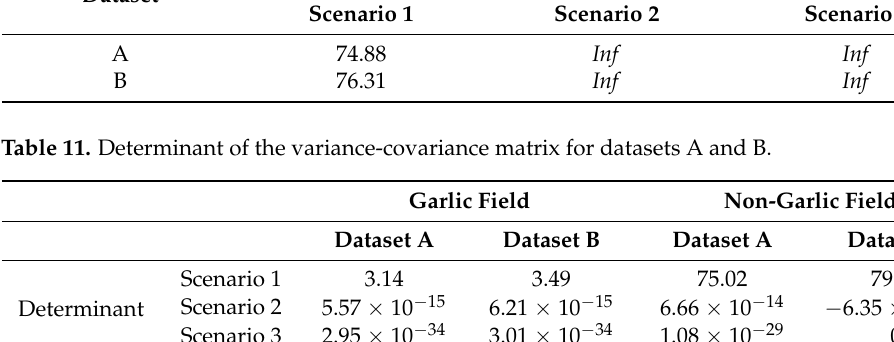
Table 10. Classification model accuracy for datasets A and B.